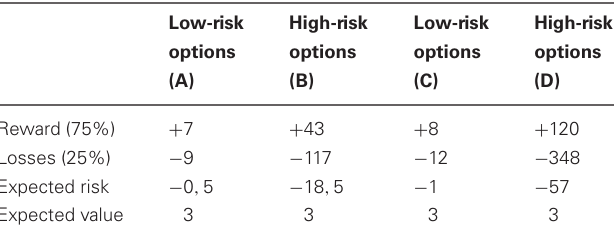
in each histogram. Choices were made by pressing one of two corresponding response buttons. After 700ms, participants were shown the outcome associated with their choice for 1100ms. A red frowny face together with a negative amount indicated negative feedback, while a green smiley face together with a positive amount indicated positive feedback. In addition, the current total amount was presented below the feedback